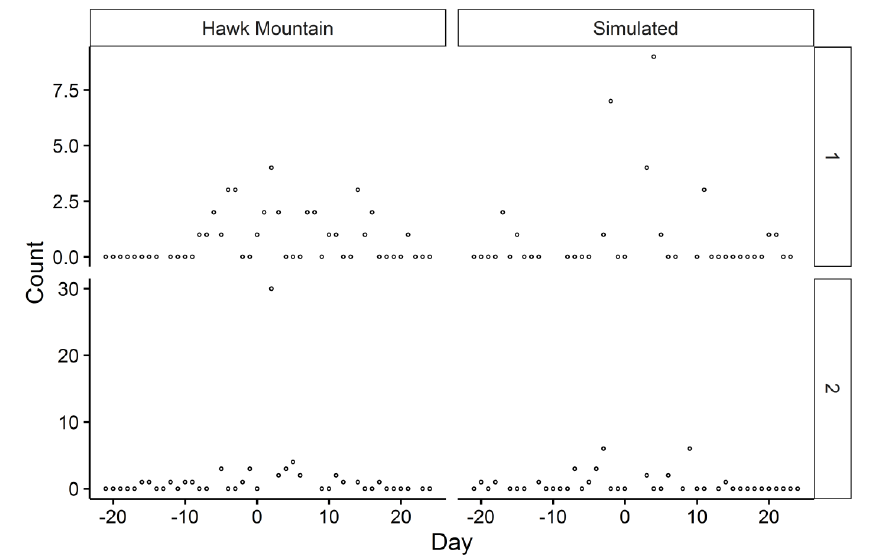
Figure A3.2. Example distribution of real and simulated daily migration counts for a rarely detected species (Peregrine Falcom). Real migration counts were collected at Hawk Mountain Sanctuary, Pennsylvania in 2000 (year 1, top panel) and 2001 (year 2, bottom panel).